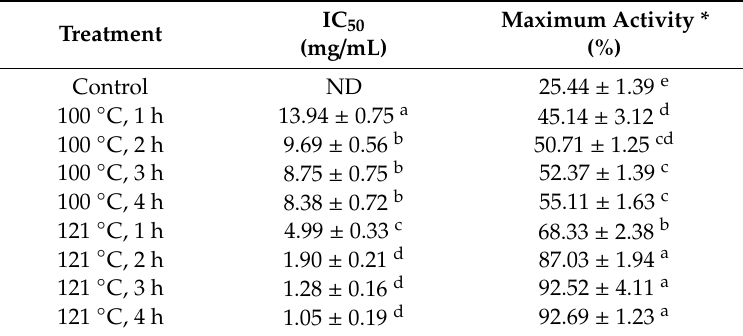
Table 2. Anti-oxidant activity of WSC and